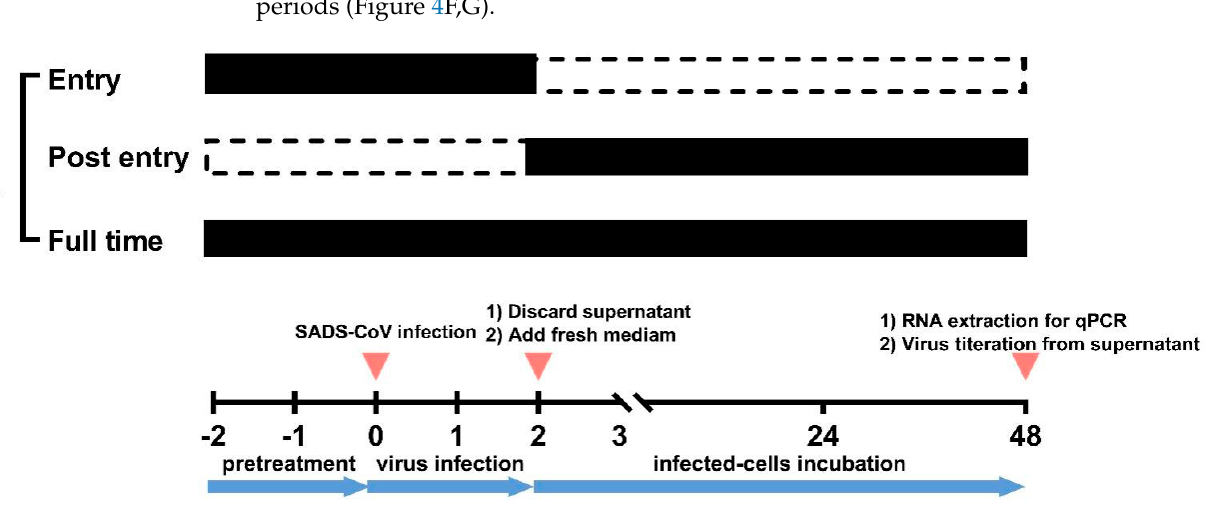
Figure 3. Procedure of the time-of-addition assay. Cells were divided into four groups with different treatments: (1) Before infection, cells of “Entry” and “Full time” groups were incubated with the indicated compounds for 2 h. (2) Cells were incubated with the indicated compounds and SADS-CoV (MOI 0.1) in the “Entry” and “Full time” groups, while cells in the “Post entry” and positive control groups were treated with the virus only. (3) After 2 h-infection, the media were replaced with fresh media with the indicated compounds in the “Post entry” and “Full time” groups, while other groups were supplemented with media without compounds. Media of the positive control groups always contained 0.1% DMSO. After 48 hpi, the supernatant and cellular RNA were collected for